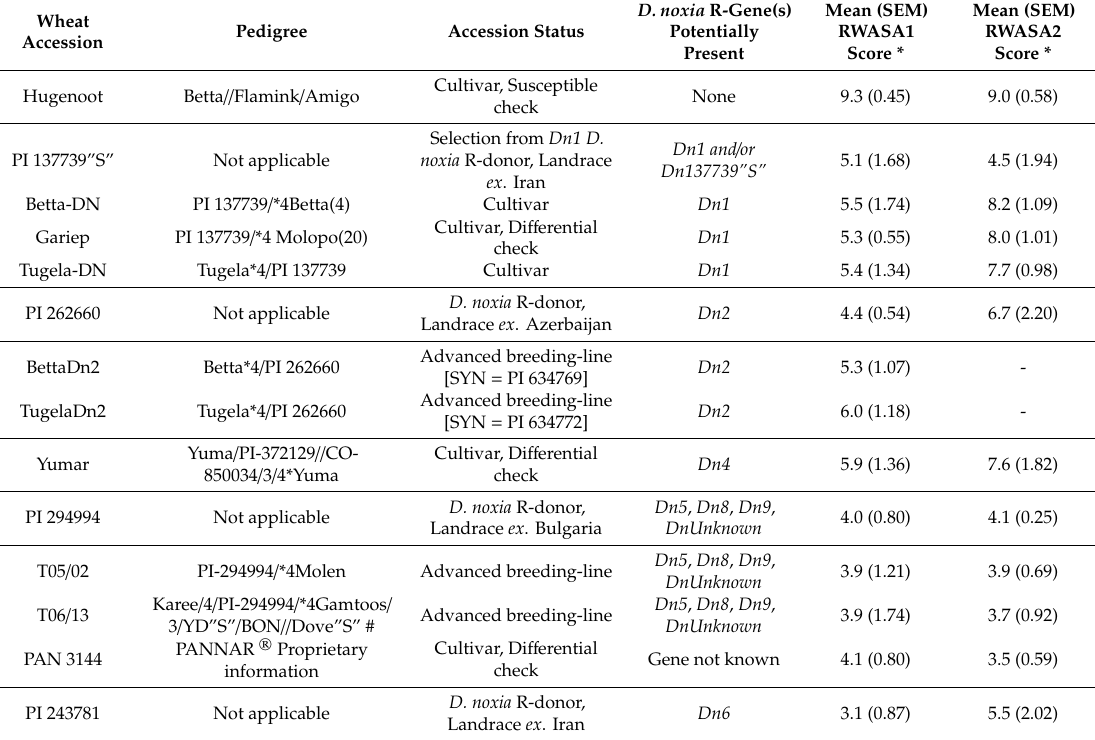
Table 5. Study panel of wheat accessions, their pedigree, accession status, postulated D. noxia gene information, and customary mean resistance reaction (SEM) to RWASA1 and